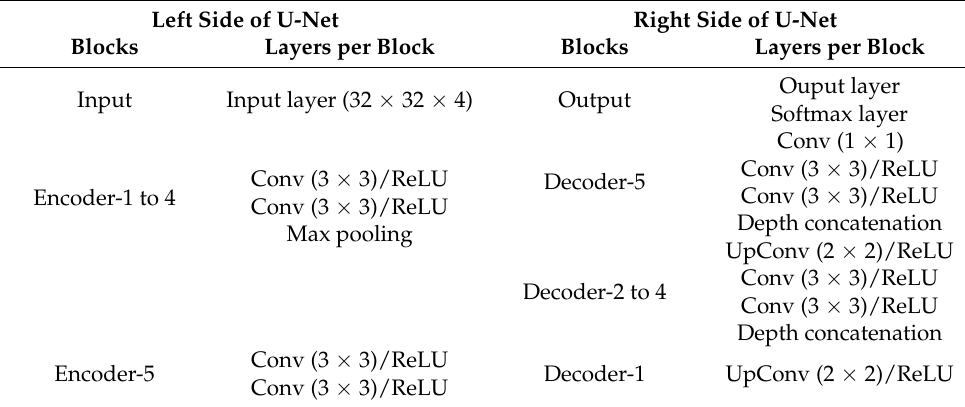
Figure 3. U-Net architecture for red tide detection from PlanetScope image. Table 3. Summary of encoder and decoder blocks of U-Net.